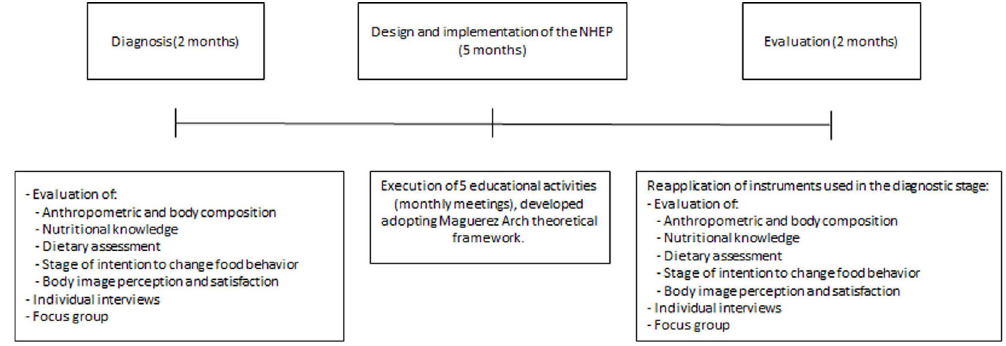
Figure 1 - Study's